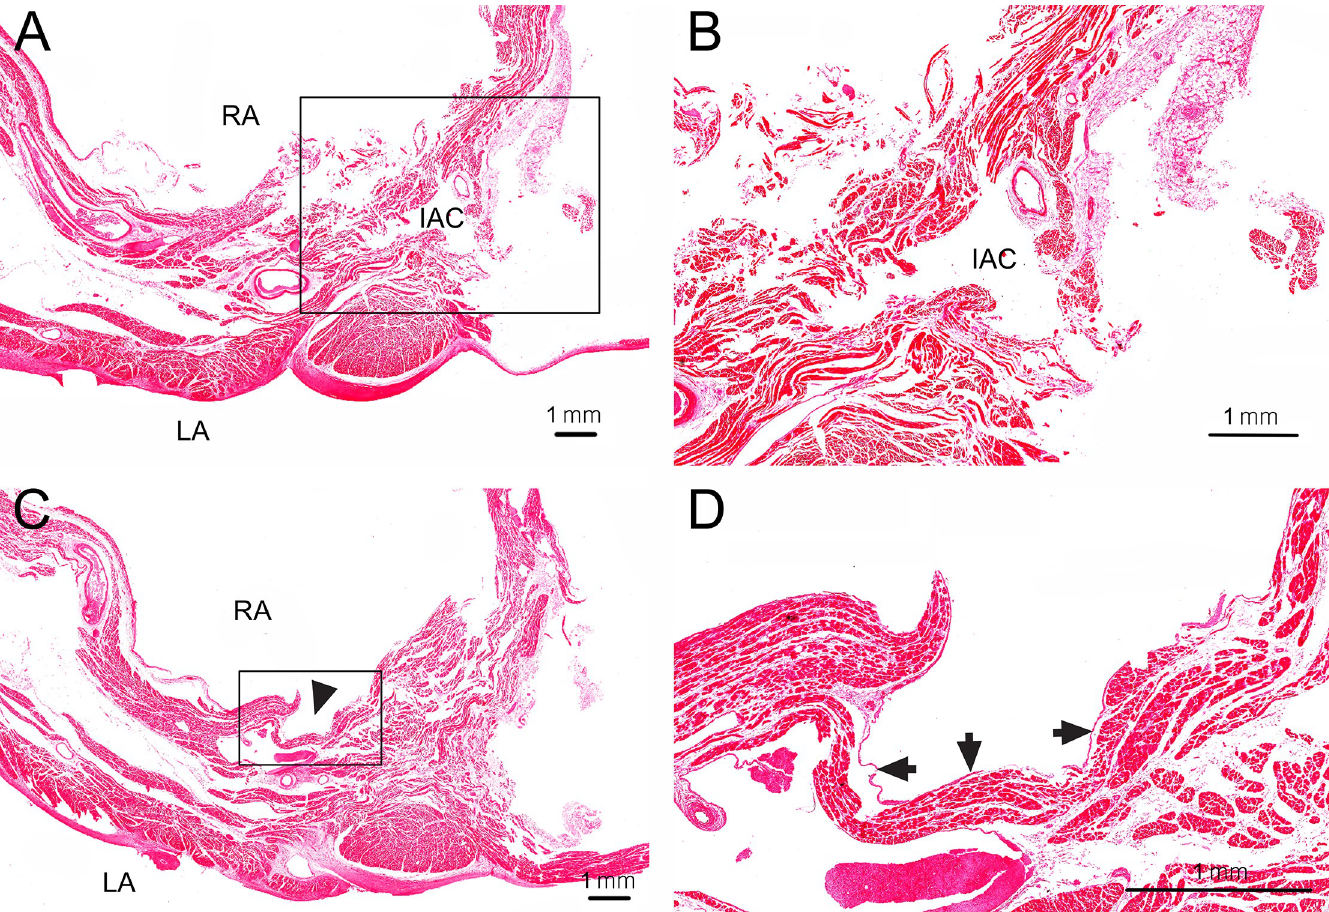
Fig 3. Transverse histological sections at the middle and lower levels of the open IAC (the same specimen as Fig 2A–2E) passing through the interatrial septum. (A) At the middle level of the open IAC, the interatrial septum could be microscopically distinguished into two parts: one able to be separated into two components and an inseparable part. The separable part was near the right border of the septum, while the inseparable part was near its left border. The IAC was always observed at the inseparable part. (B) Enlarged view of the rectangular inset in A. The wall of the IAC involved muscular tissues running in different directions. Endothelium was not observed in the wall of the IAC. LA, left atrium; RA, right atrium. (C) At the lower level of the open IAC, a hole (arrowhead) of the open IAC was observed on the right surface of the interatrial septum. (D) Enlarged view of the rectangular inset in C. Endocardium (arrows) was observed adjacent to the hole of the